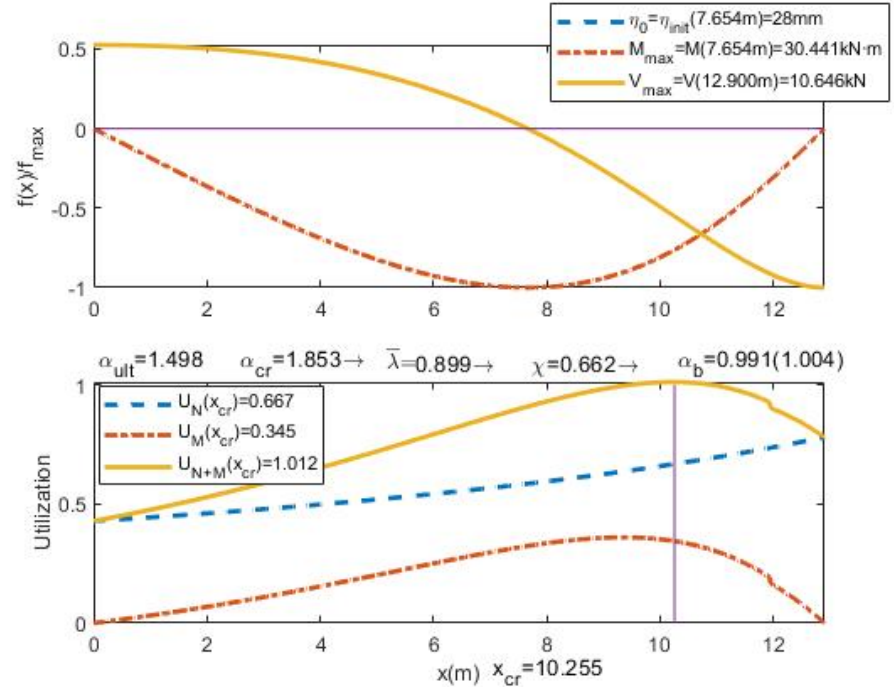
Figure 11. Example 4.1: UGLI imperfection η init , bending moment M , shear force V , utilization factor U . Value (1.004) is obtained by Geometrically and Materially Nonlinear Analysis with Imperfections (GMNIA).